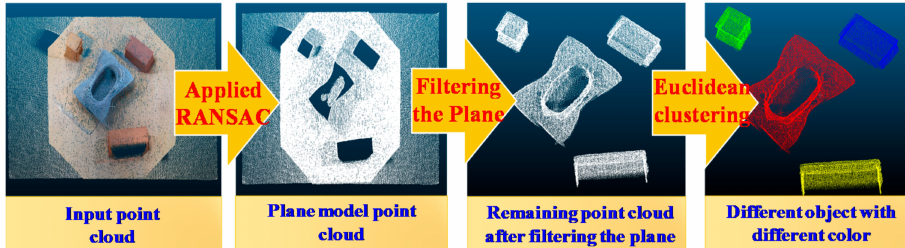
Figure 4. Effect of object segmentation in the study of dynamic workpiece